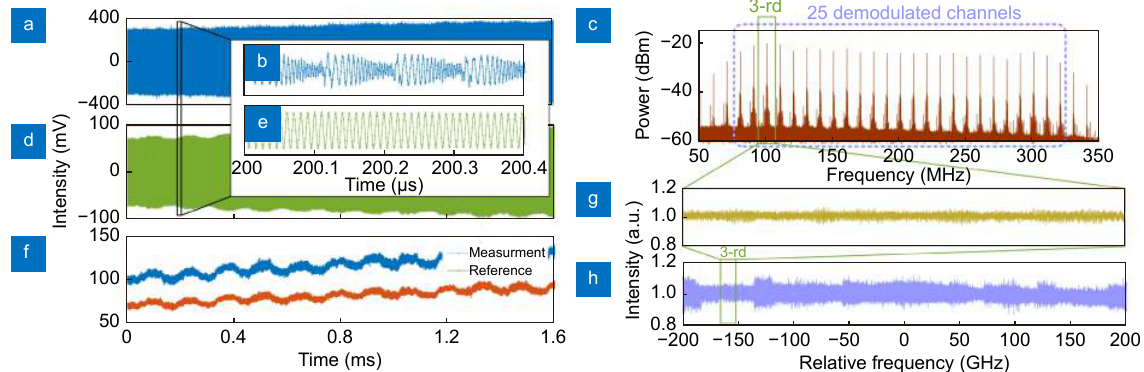
Fig. 4 | ( a ) Temporal waveform of dual-comb interferometer recorded in 1.6 ms with a sampling rate of 1 GS/s. ( b ) Zoom-in figure of (a) in 0.4 μs. ( c ) Electrical spectrum of reference branch containing total 25 lines centered at about 200 MHz. ( d ) Temporal waveform and ( e ) zoom-in figure of the 3-rd channel obtained by digital filtering. ( f ) Envelopes of the 3-rd channel for measurement and reference branches obtained by digital Hil- bert transformation. Demodulated spectrum without DUT at 1 MHz spectral resolution for ( g ) the 3-rd channel in 16 GHz bandwidth and ( h ) all channels covering 400 GHz bandwidth, in which the standard deviation is calculated to be 2.316